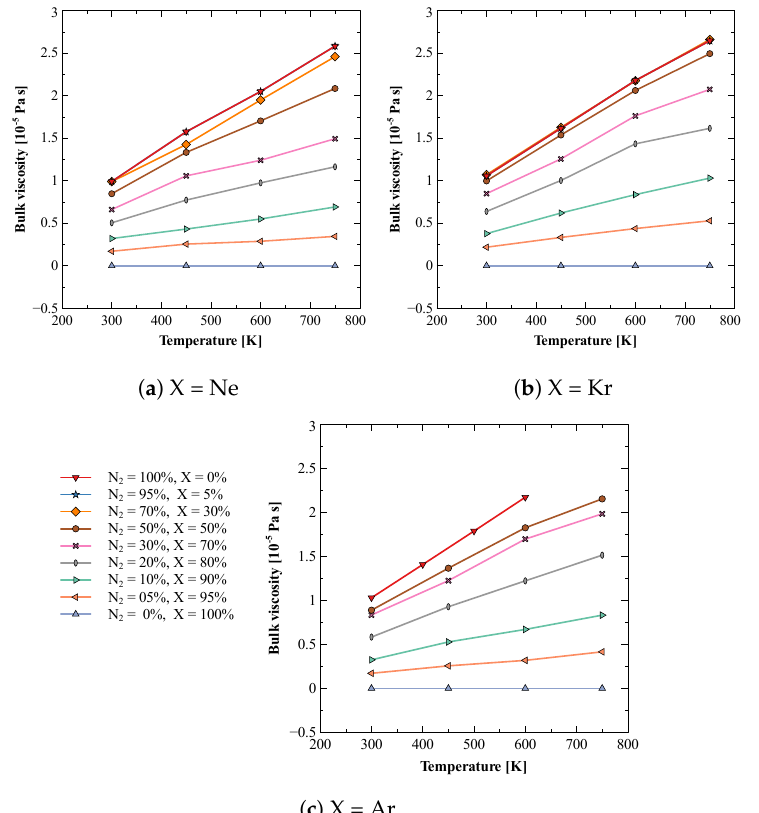
Figure 2. Bulk viscosity of different compositions of mixture of nitrogen (N 2 ) and noble gases (X). ( a ) N 2 + Ne ( b ) N 2 + Kr ( c ) N 2 +